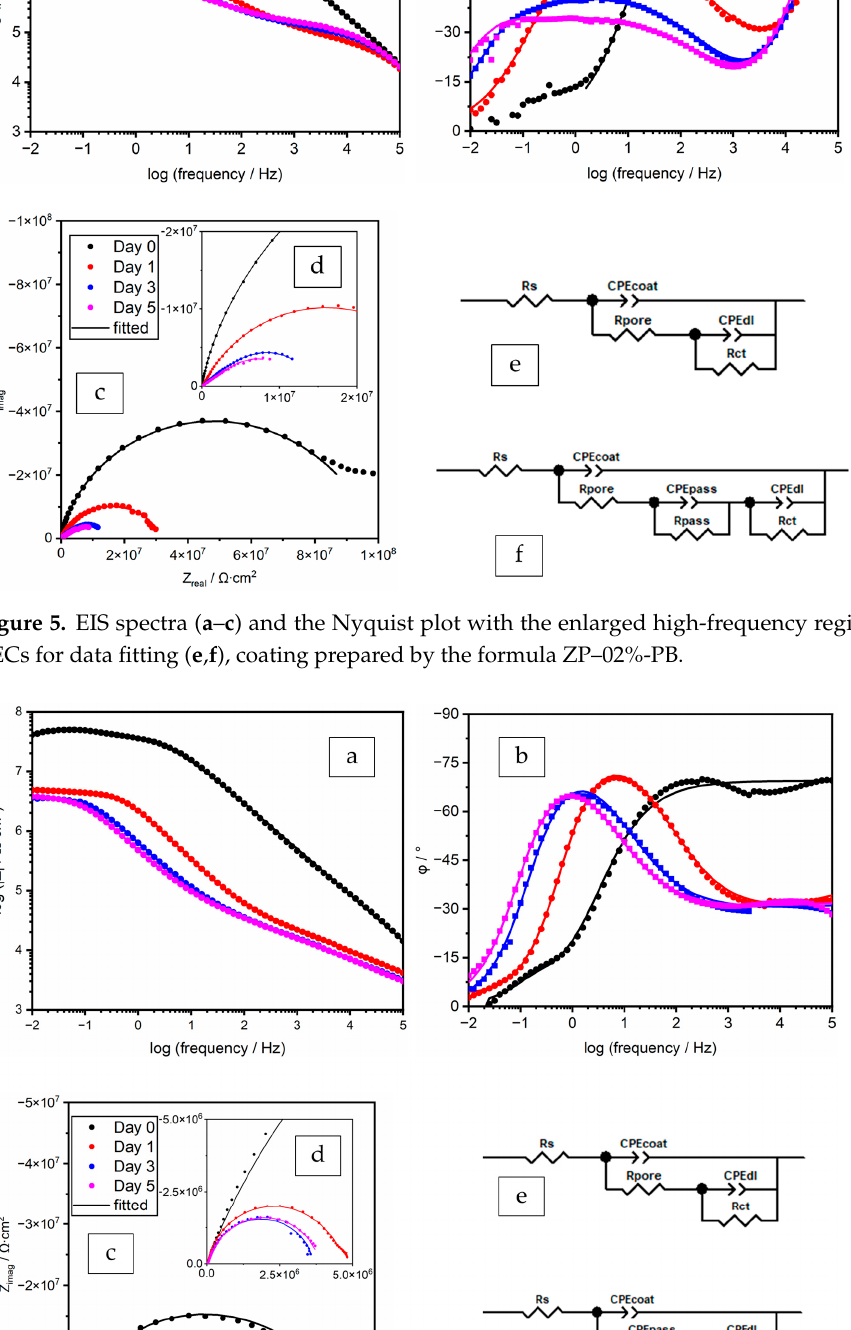
Neutral salt spray tests were performed on the test panels with the same three series of formulae PC, PB and EB. Three identical panels of each formula were tested in parallel, and the creepages were measured every 500 h. The elapsed times to reach a mean creepage value of 2 mm are plotted in Figure 7, and Figure 8 presents the panel photographs after the test. The salt spray results were different from those obtained by electrochemical meth- ods. In PC (polyester/TGIC clearcoat), only the ZP dosage of 2% reached the salt spray hours of 1000 h, but the additive showed no effect at any other dosages. In contrast, with